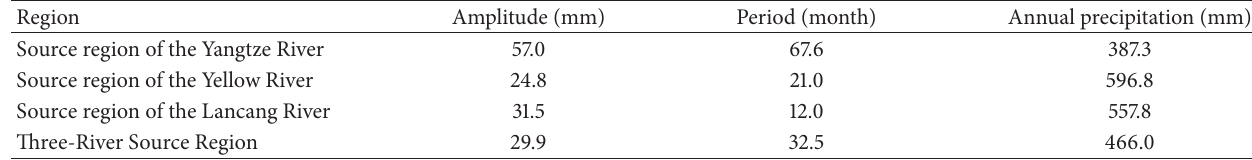
Table 4: Period of water storage change over the subregions of the Three-River Source Region during 2003–2010.